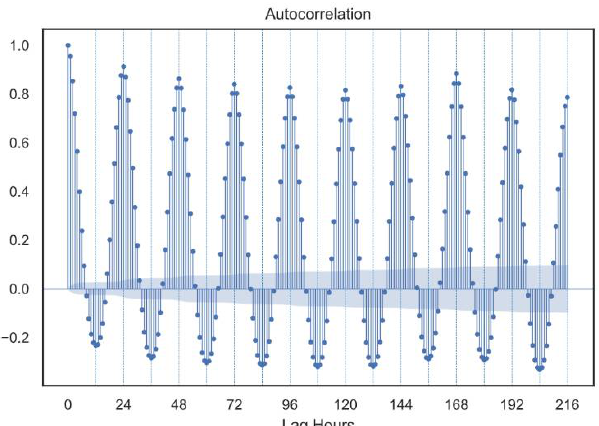
Figure 12. Autocorrelation of the electrical time-series signal with previous hours. Lagged demands at (−1, −24, −168, −48) hours showed the highest correlation, respectively, representing the demand at the same hour in the previous two days in the current week and the same day in the prior week. Table 5 illustrates the exogenous features related to demand at the hour to be predicted. The endogenous features related to the demand at previous hours of the week are given in Table 6. Table 5. Exogenous related to demand at the hour to be predicted.